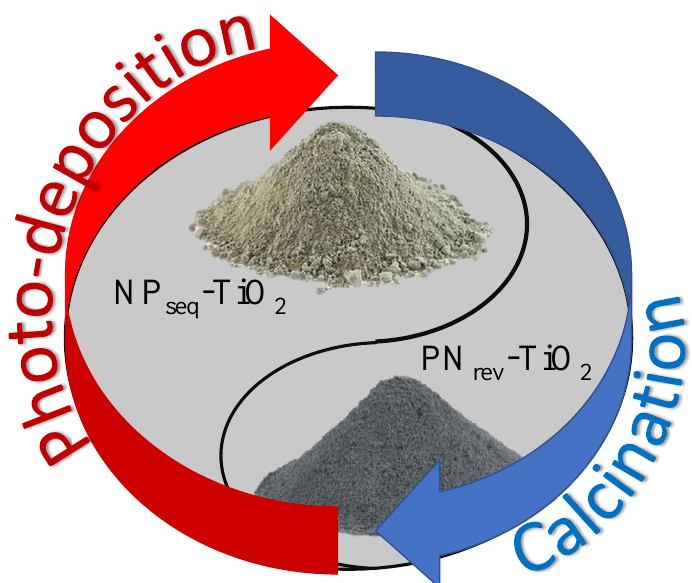
Figure 2. The mode preparation for NP seq -TiO 2 and PN rev -TiO 2 photocatalysts.